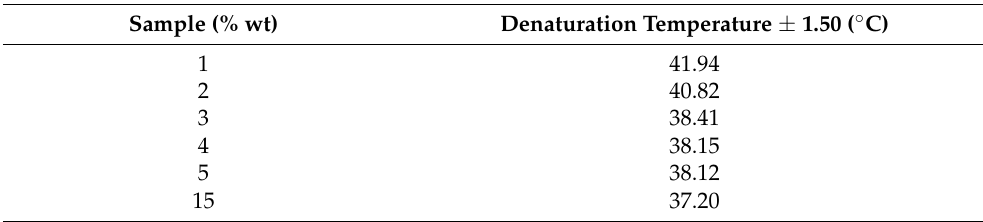
Table 2. Value of the denaturation temperatures measured for each concentration of the studied collagen masses .